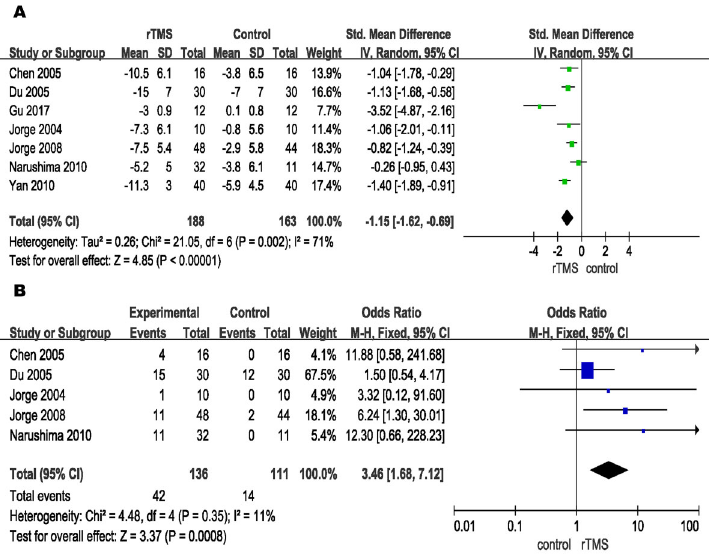
Figure 2. A , Comparison of repetitive transcranial magnetic stimulation (rTMS) and control conditions for primary ef fi cacy outcome and B , remission of depression in post-stroke depression patients based on change in scores in related rating scales. See Table 1 for corresponding numbers of